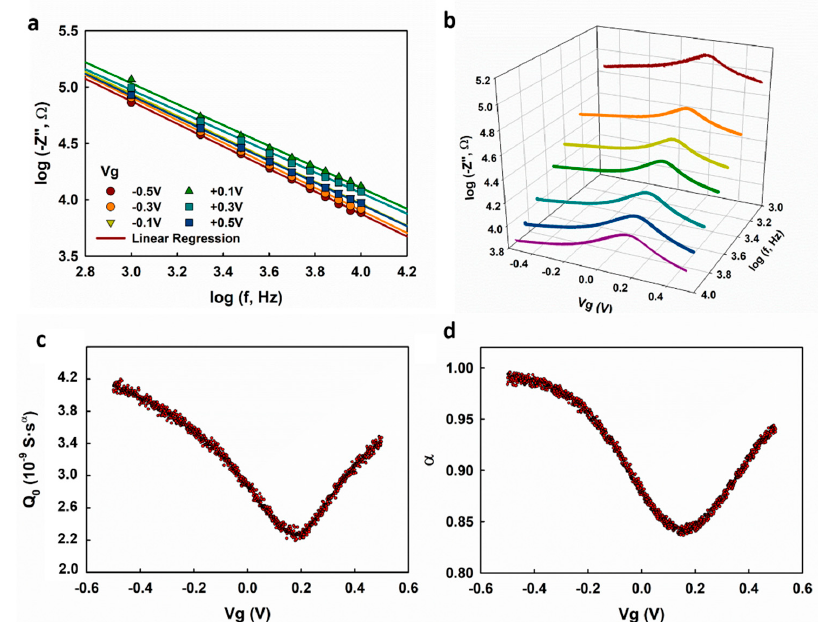
Figure 5. ( a ) log ( − Z (cid:48)(cid:48) ) vs. log f plot measured by frequency sweeping at selected gate voltages; Figure 5. ( a ) log(cid:4666)(cid:3398)𝑍”(cid:4667) vs log𝑓 plot measured by frequency sweeping at selected gate voltages; ( b ) ( b ) log ( − Z (cid:48)(cid:48) ) vs. log f plot measured by gate voltage sweeping at selected frequencies; ( c , d ) Q 0 and α log(cid:4666)(cid:3398)𝑍”(cid:4667) vs log𝑓 plot measured by gate voltage sweeping at selected frequencies; ( c , d ) 𝑄 (cid:2868) and 𝛼 were extracted based on multi-frequency C-V profiling were extracted based on multi-frequency C-V profiling method.